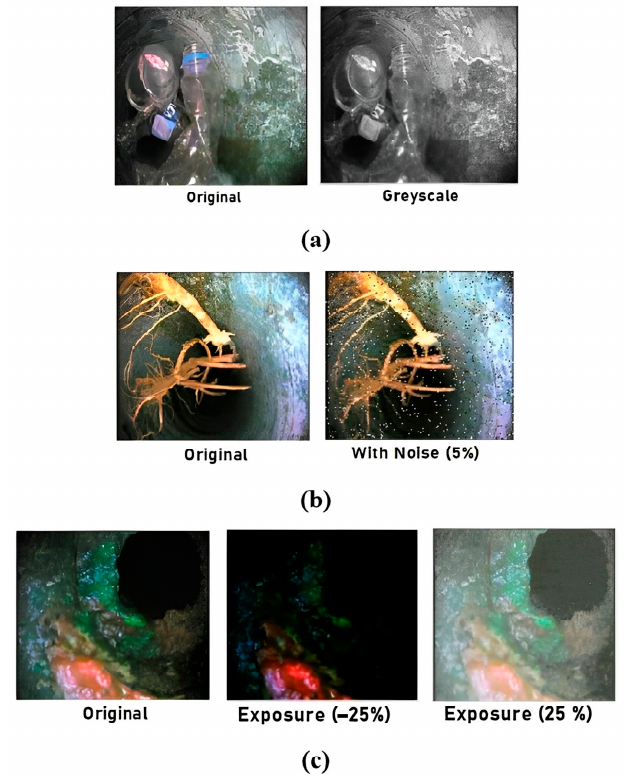
Figure 12. Visual upshots of standard augmentation techniques: ( a ) greyscaling, ( b ) salt and pepper noise, ( c ) random exposure.